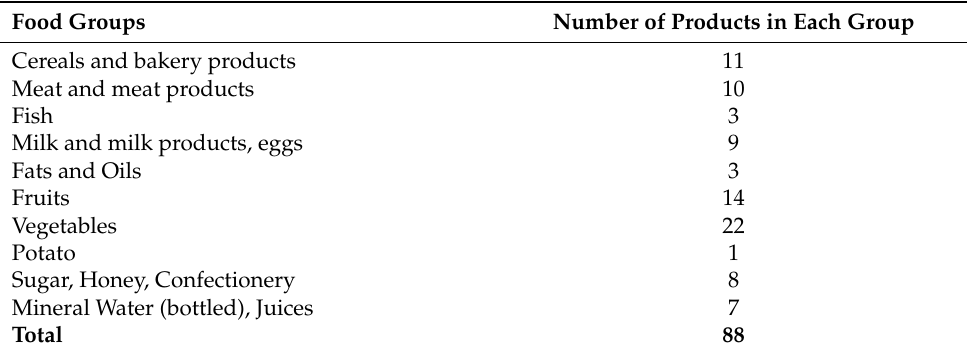
Table 1. Number of products in each food group.